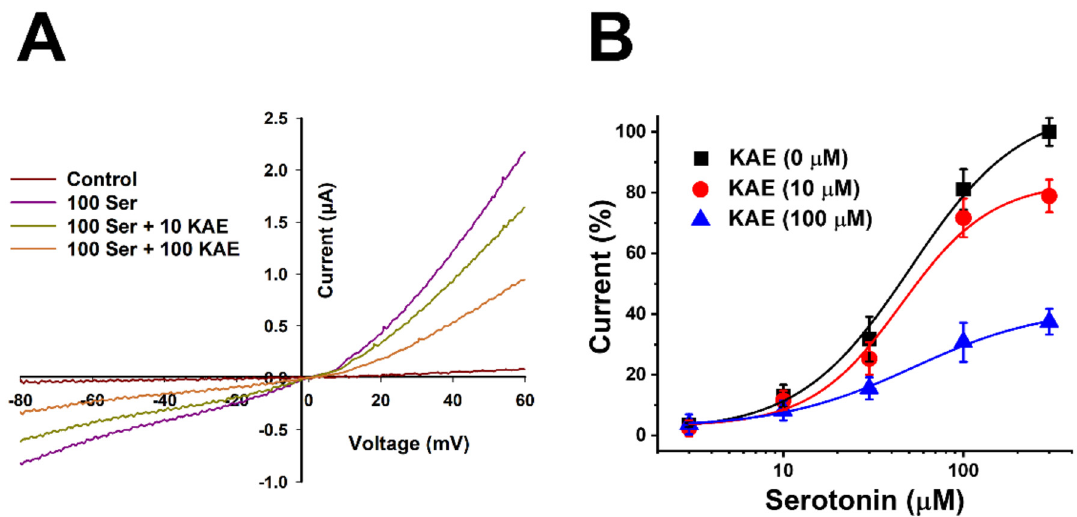
Figure 2. ( A ) Effects of voltage on the relationship of KAE with human 5-HT 3A receptor. Different voltages ranging from − 80 mV to +60 mV were applied to oocytes injected with water (control) or 5-HT 3A mRNA using the voltage clamp ramp protocol. The holding potential of the mem- brane was fixed at − 80 mV. The color of each line indicates the applied condition (red = water injection, purple = 100 µ M serotonin applied, green = 100 µ M serotonin and 10 µ M KAE applied, orange = 100 µ M serotonin and 100 µ M KAE applied; n = 8–10 oocytes from four different frogs). ( B ) Confirmation of a non-competitive interaction between KAE and human 5-HT3A. In oocytes injected with human 5-HT 3A mRNA, the concentration of KAE was fixed at 0 µ M ( (cid:4) ), 10 µ M ( • ), or 100 µ M ( (cid:78) ) while the concentration of serotonin ranged from 1 to 300 µ M. Membrane holding potential was fixed at − 80 mV. Each point represents the current percentage and error value due to change in the concentration of serotonin. Data are presented as mean ± SEM ( n = 7–9 oocytes from four different frogs) according to statistical